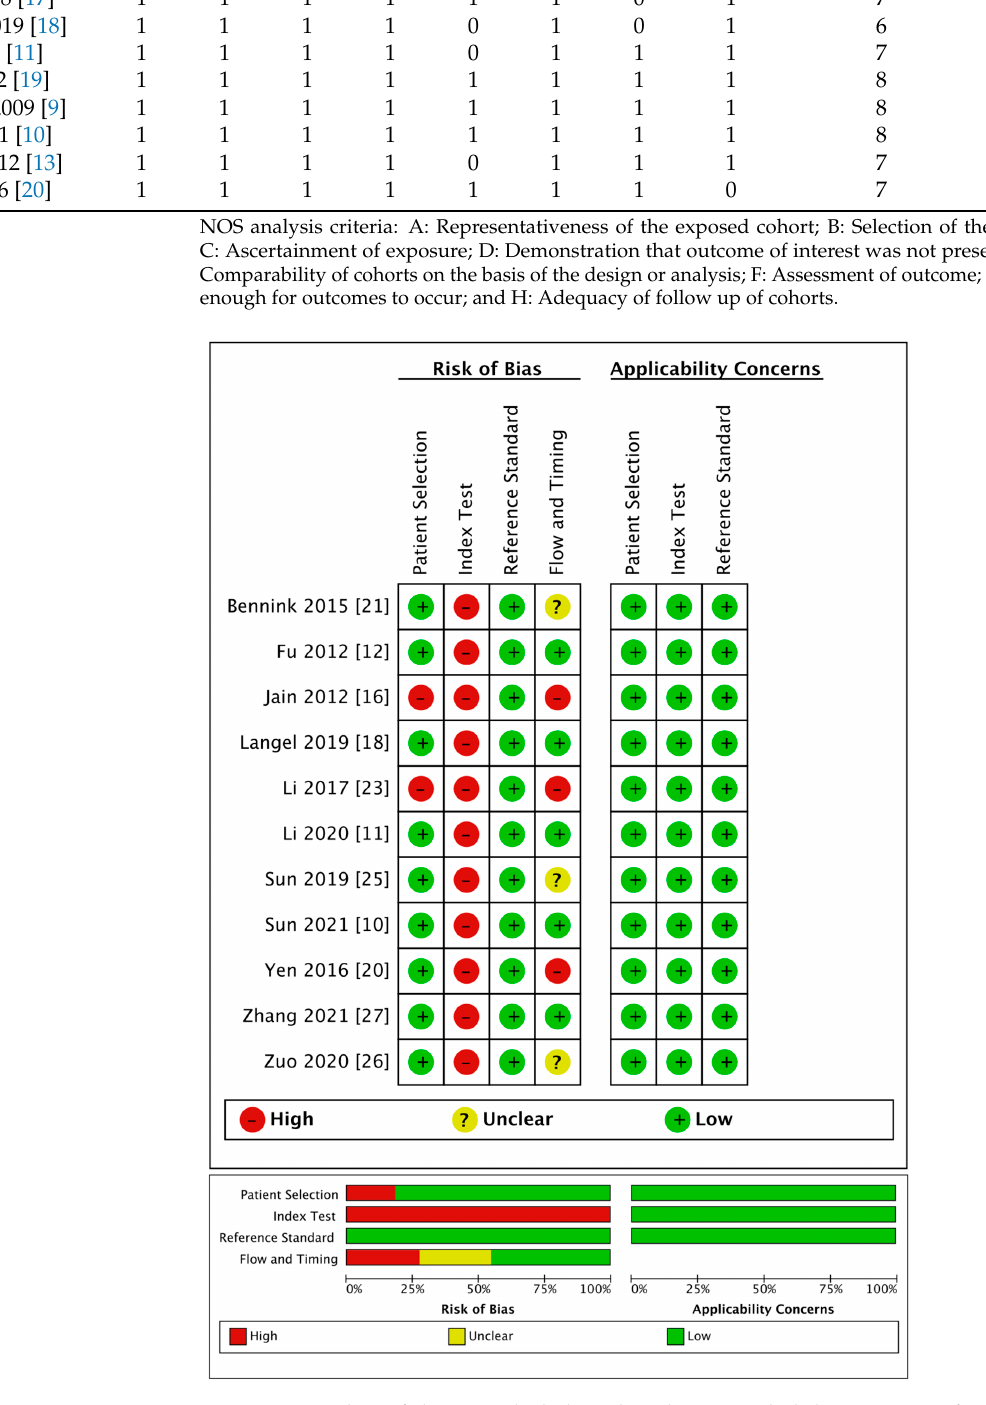
Figure 2. Quality of the 11 included studies that provided diagnostic performance of rPS, rCBF, or rCBV.